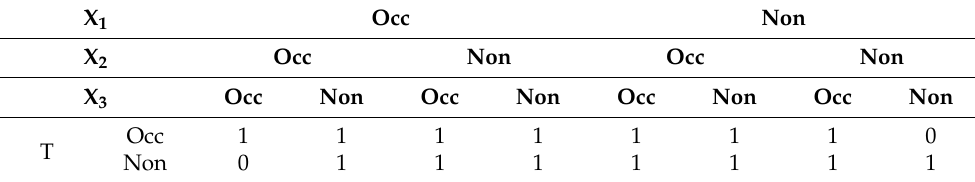
Table 2. CPT corresponding to the OR gate in FT (Occ: occurred; Non: non-occurred). X 1 Occ Non X 2 Occ Non Occ